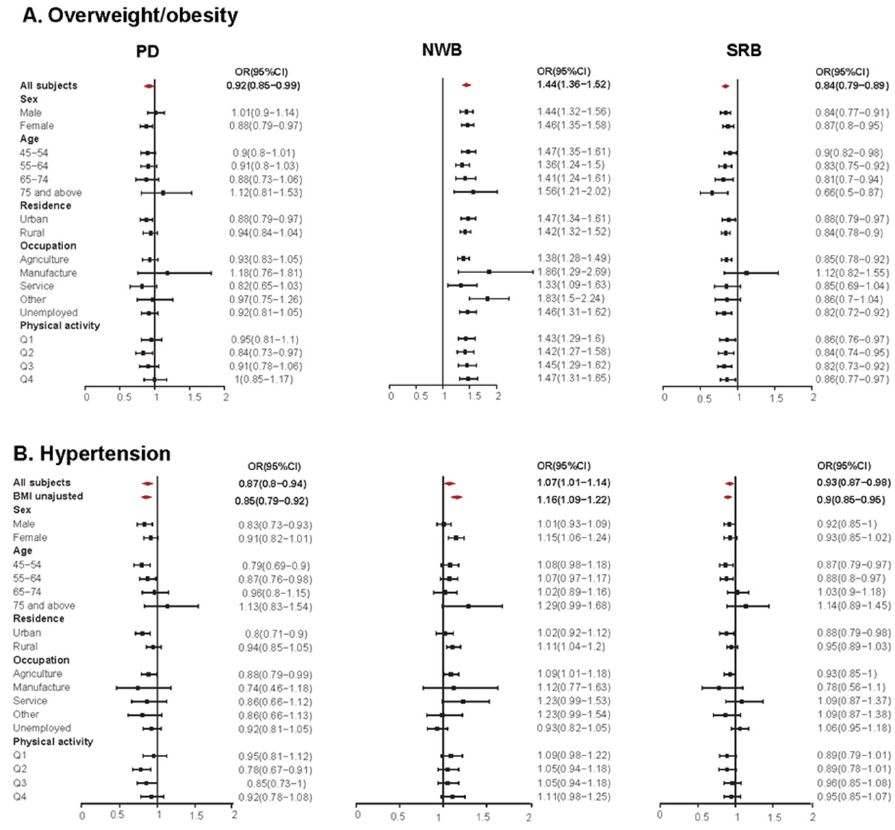
Figure 5. Estimated associations of dietary patterns with overweight/obesity, abdominal obesity, and hypertension among study population, with CRB as reference group. Analyses were adjusted for sex, age, ethnic group, education level, household income per capita, occupation, smoking behavior, drinking behavior, physical activity, total energy intake, and family history of cardiovascular disease and diabetes. The diamond and block represented the estimated odds ratios in overall and subgroup analyses, respectively. Q1–Q4: quartiles. CRB: Common rice-based dietary pattern; PD: Prudent diversified dietary pattern; NWB: Northern wheat-based dietary pattern; SRB: Southern rice-based dietary pattern; BMI: body mass index; OR: odds ratio; CI: confidence interval.